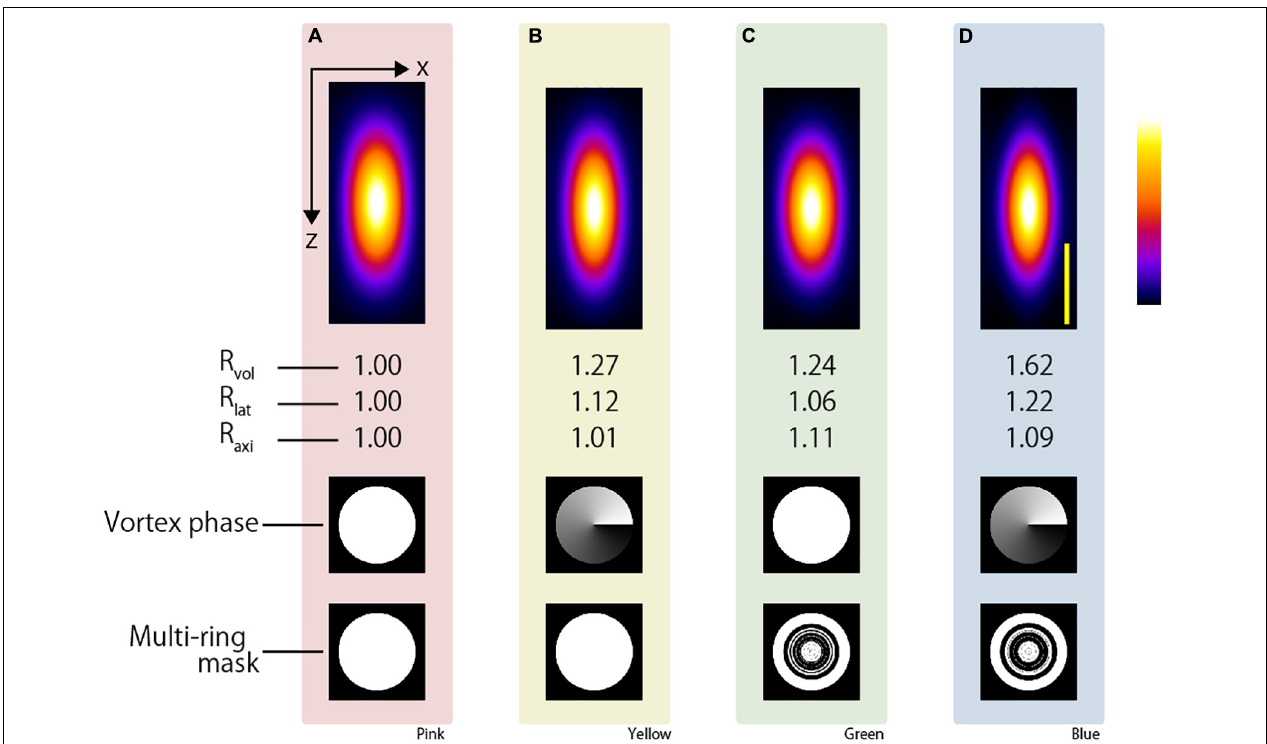
FIGURE 2 | Simulation result of two-photon PSF when the silicone immersion objective lens with NA = 1.3 was used to focus the (A) CP, (B) APV, (C) AMCP, and (D) AMAPV excitation beams. Top: an x-z projected images of the two-photon PSF. Middle: phase patterns for realizing the first resolution-enhancement method. White and black indicate a phase difference of 0 to 2 π . Bottom: multi-ring mask patterns for realizing the second resolution-enhancement method. White and black areas represent the transmission and light-shielding areas, respectively. Scale bar: 500 nm. Similarly in the following figure, the images surrounded by pink, yellow, green, and blue backgrounds show the results obtained using the CP, APV, AMCP, and AMAPV excitation beams,